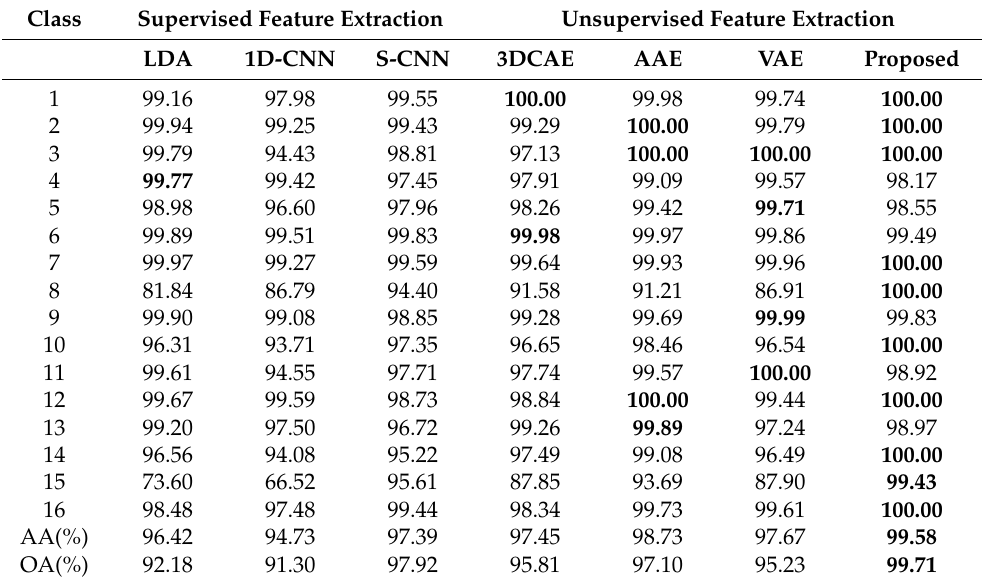
Table 4. Classification results of different models in SV. Some of the data in the table were obtained from [16]. The best values in each row are